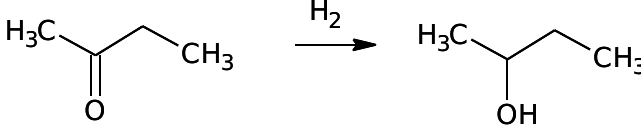
Figure 8. Scheme of 2-butanone hydrogenation.